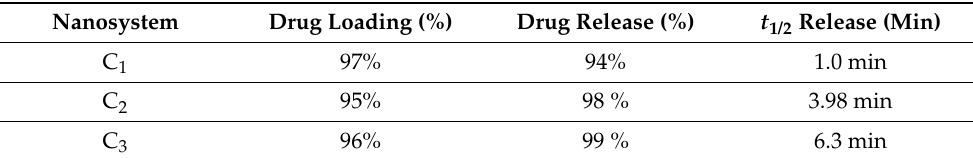
Table 1. Drug loading and release parameters for different formulations of Au@16-Ph-16/DNA–5- Fu-compacted